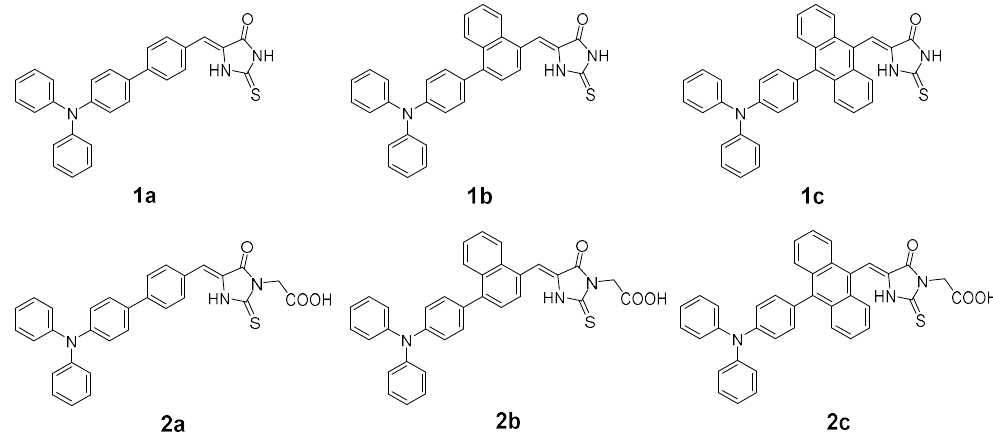
Figure 1. Chemical structures of the examined compounds.